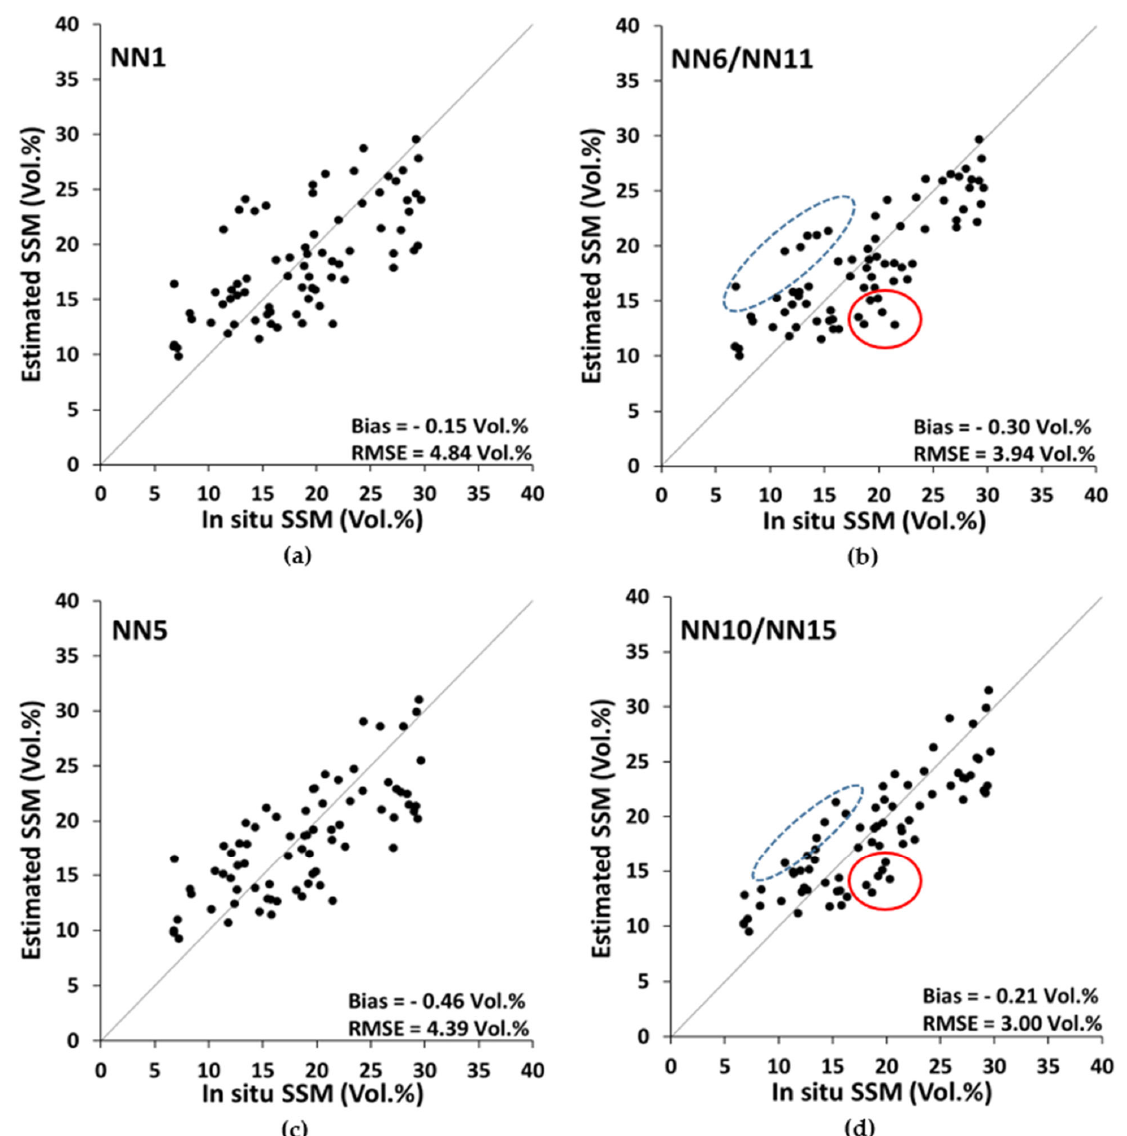
Figure 10. Retrieved SSM with the inversion performed using C ‐ band real SAR data in the versus in situ measurements. ( a ) NN without Hrms in input and no a priori information on SSM; ( b ) NN without Hrms in input and a priori information on SSM; ( c ) NN with noisy Hrms in input and no a priori information on SSM; ( d ) NN with noisy Hrms in input and a priori information on SSM.